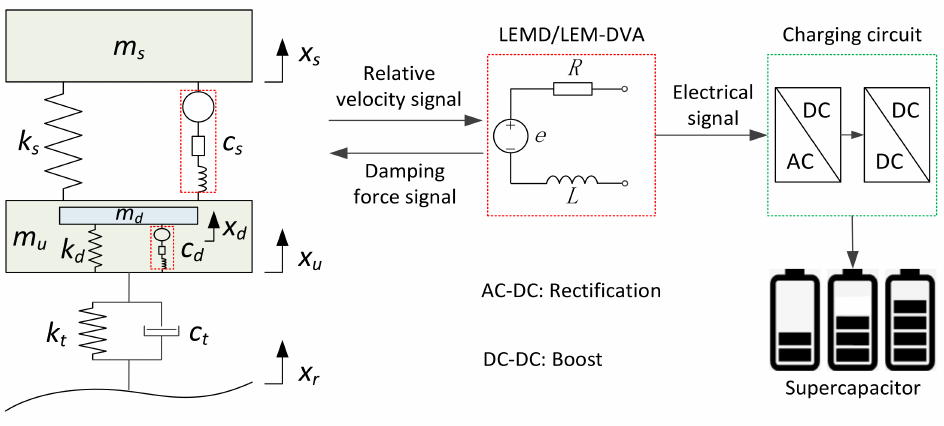
Figure 6. Principle of energy